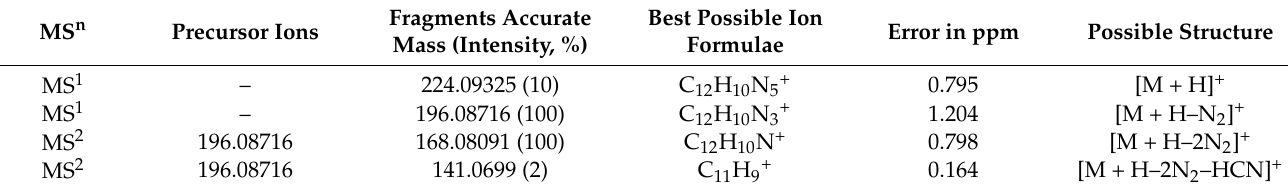
Scheme 4. Proposed fragmentation pathways for the 3-(5-phenyl-2 H -tetrazol-2-yl)-pyridine 1 . Table 4. ESI–MS n data (relative abundance, %). Table 4. ESI–MS n data (relative abundance,